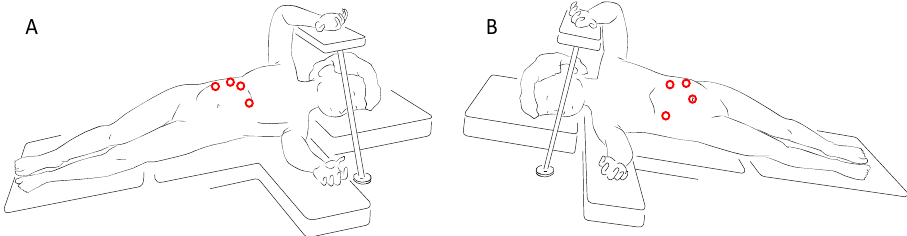
Figure 3. Trocars site for right ( A ) and left ( B ) lateral laparoscopic adrenalectomy.